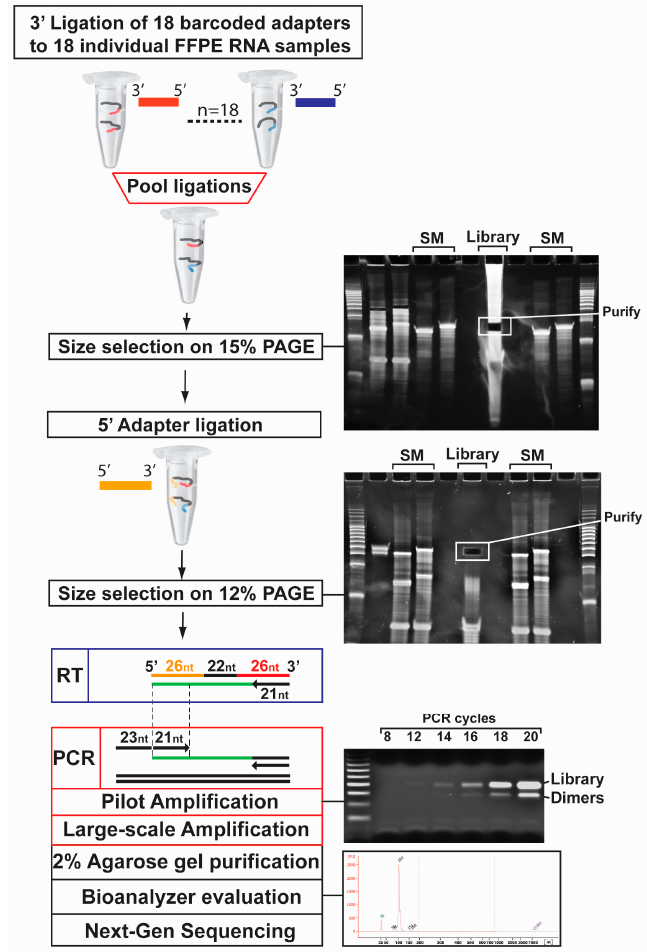
Figure 1. Illustrated representation of the optimized barcoded cDNA library preparation procedure. Total RNA from formalin-fixed paraffin-embedded (FFPE) specimens ( n = 18), are ligated with 3 ′ adapters ( n = 18), purified on a 15% PAGE gel (using size markers (SM) RNA oligonucleotides) and excised after SYBR ® gold staining of the gel. The combined purified products are ligated with a 5 ′ adapter, run on a 12% PAGE gel, excised and purified. The dual-adapter ligated small-RNA products are reverse transcribed, subjected to a pilot PCR for identification of adequate amplification cycle. A